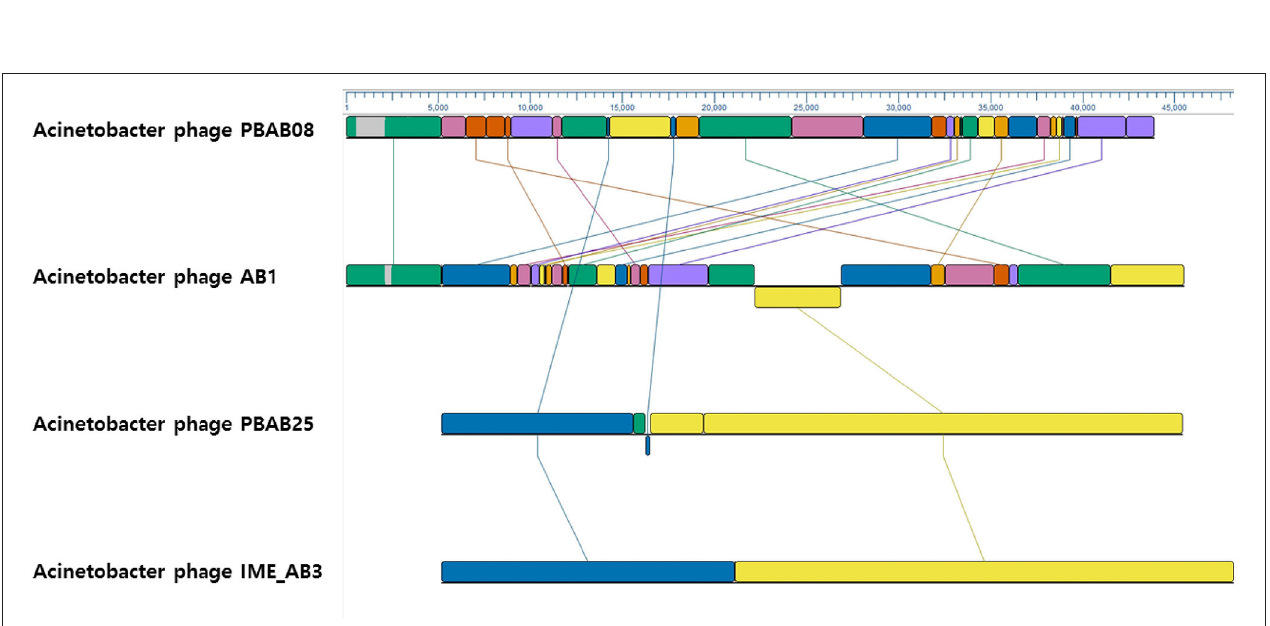
FIGURE 3 | Genomic sequence comparison between phages PBAB08, AB1, PBAB25, and IME_AB3 using MAUVE. Line-connected colored boxes indicate regions of sequence similarity in corresponding phage genomes.